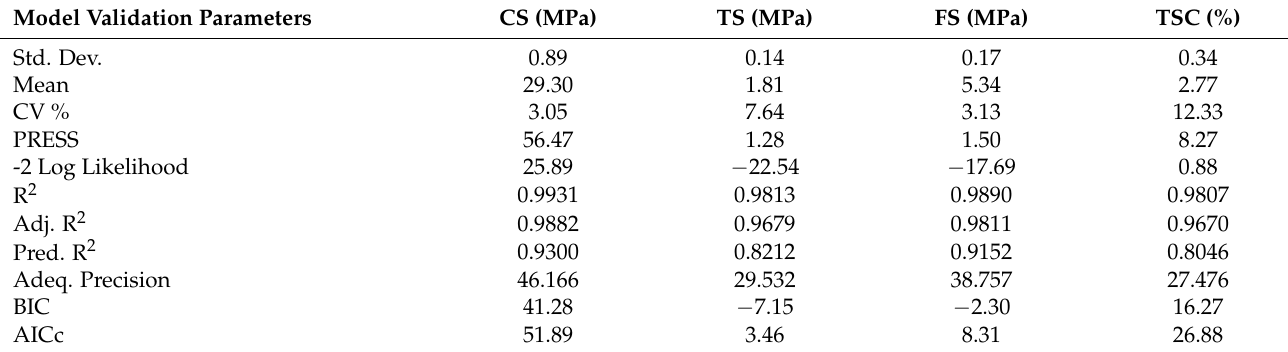
Table 6. Model validation parameters.